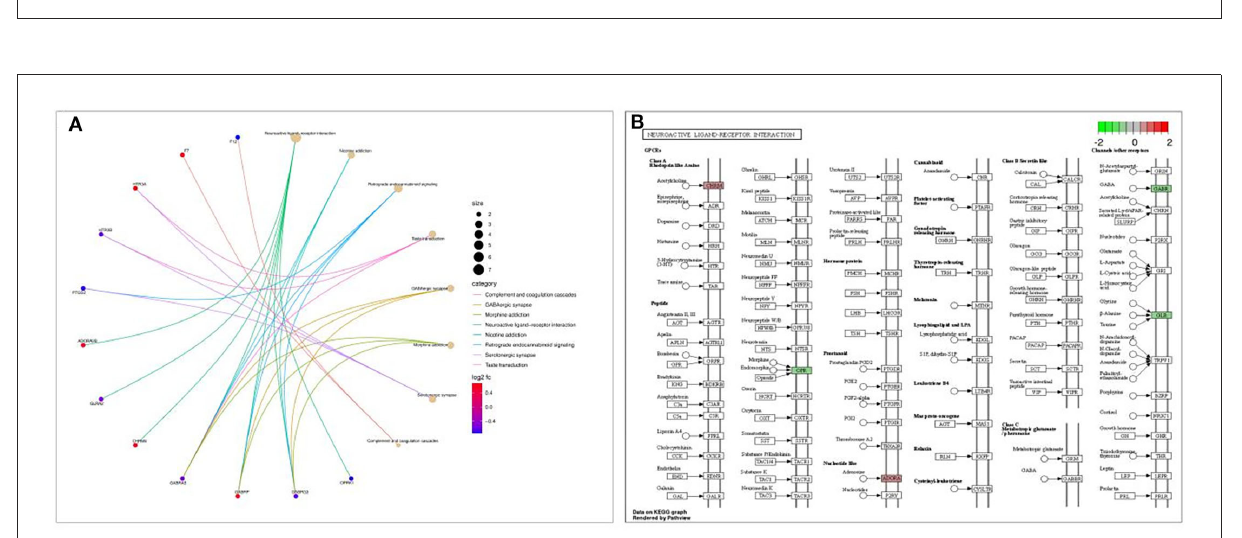
FIGURE6 Enrichment analysis. (A) KEGG enrichment analysis bubble diagram. (B) Neuroactive ligand-receptor interaction signaling